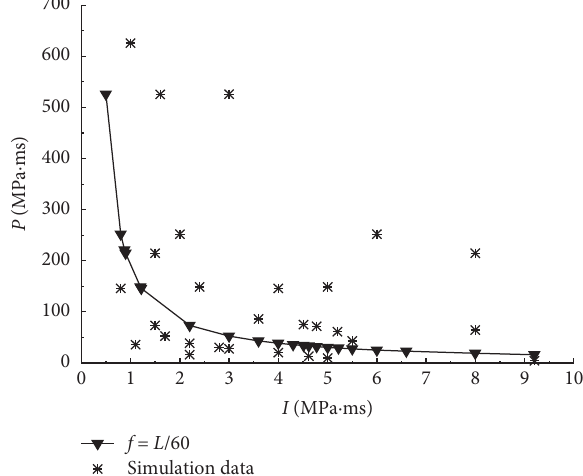
Figure 19: Pressure-impulse (P-I) curve of the CFDST column.